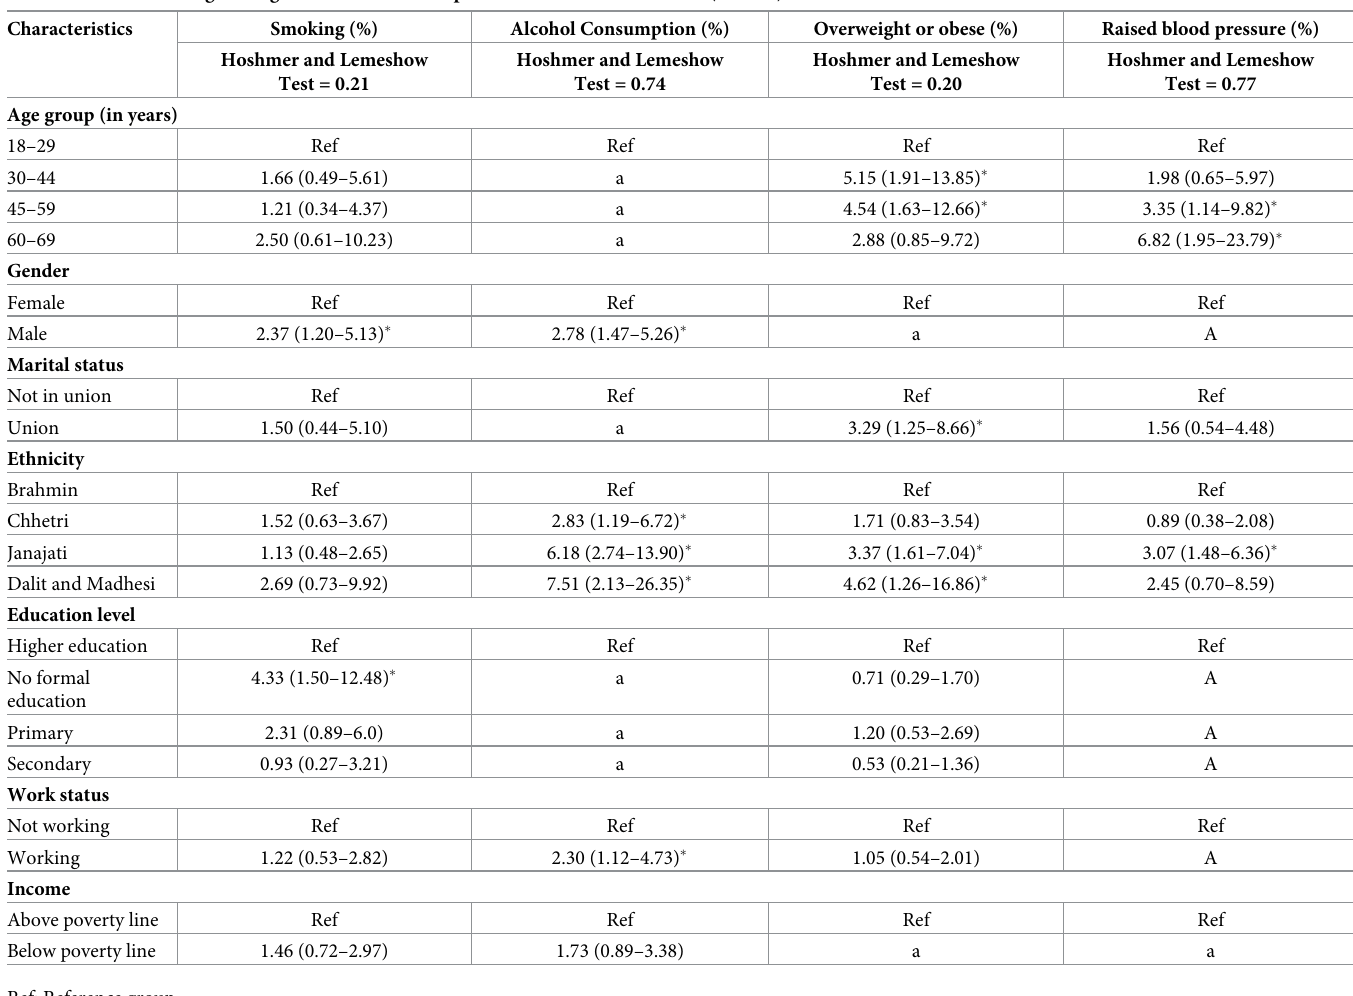
Table 4. Multivariate logistic regression to determine predictors of NCD risk factors (n = 245).